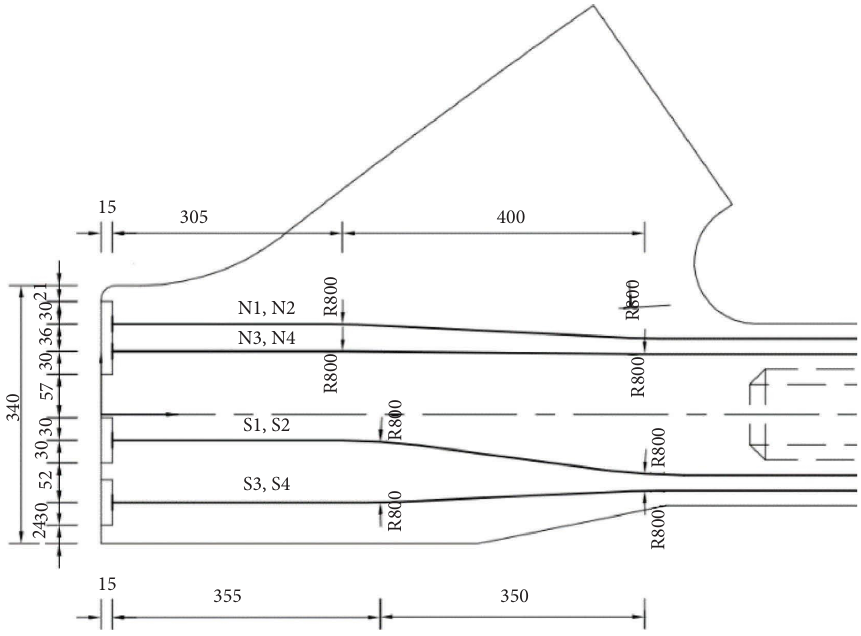
Figure 6: Bending diagram of prestressed steel wires at arch